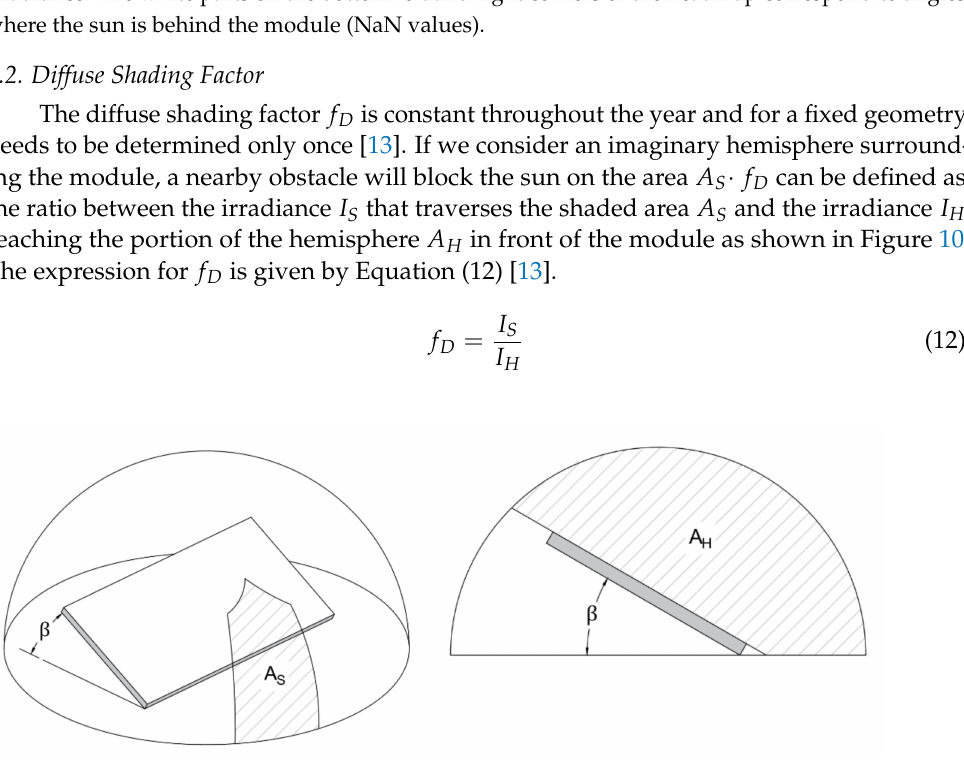
Figure 10. Calculation of the shading factor for the diffuse irradiance. If the solar module is covered by an imaginary hemisphere, then one nearby obstacle will reduce the diffuse irradiance reaching this hemisphere. A S is the portion of the hemisphere where the sun is blocked by the obstacle. The diffuse irradiance shading factor is given as the ratio between the irradiance traversing A S and the irradiance traversing the hemisphere A H